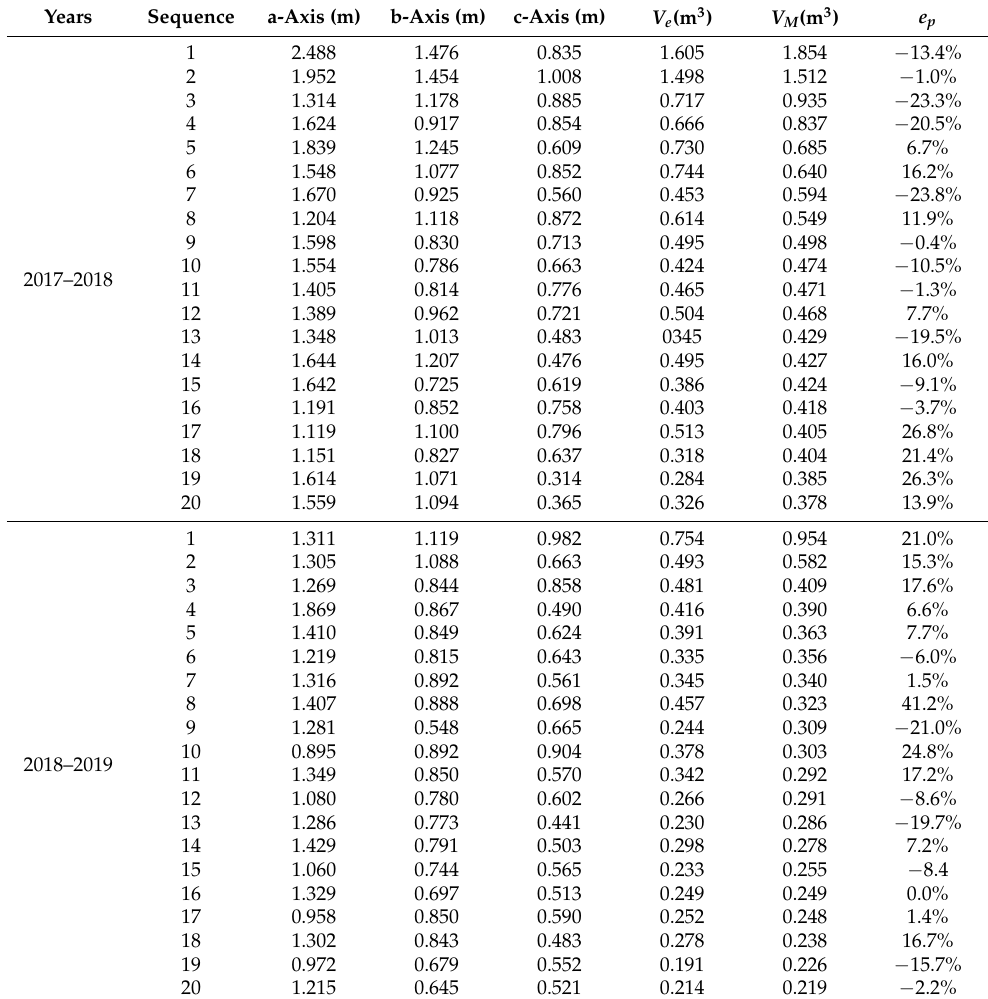
Table 2. The 20 largest boulders in the two comparisons, with the axial length, estimated volume ( V e ), M3C2 volume ( V M ), and error percentage ( e p )